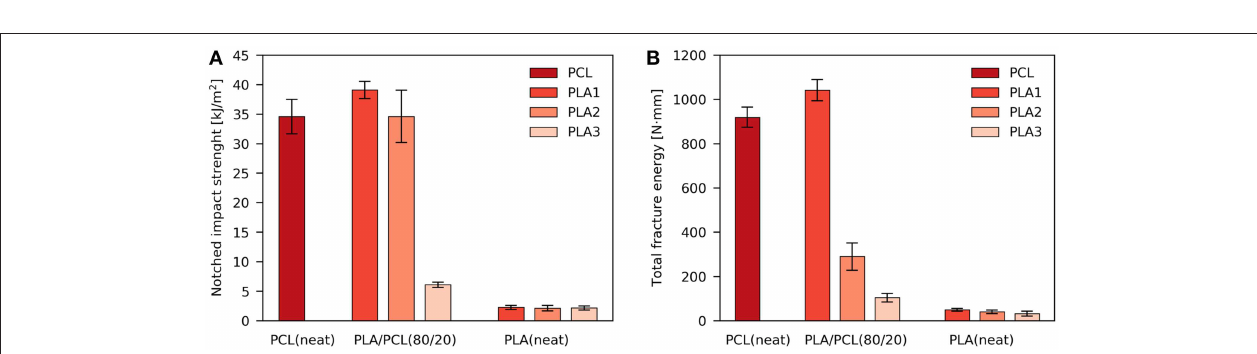
FIGURE 4 | SEM micrographs (A–C) and corresponding particle size distributions (D–F) of PLA/PCL (80/20) blends prepared from three different PLAs with decreasing viscosity [ η (PLA1) > η (PLA2) > η (PLA3)]. The abbreviations 2dN% and 2dV% denote number and volume distributions, respectively. Reprinted with permission from Ostafinska et al. (2017). Copyright 2017,